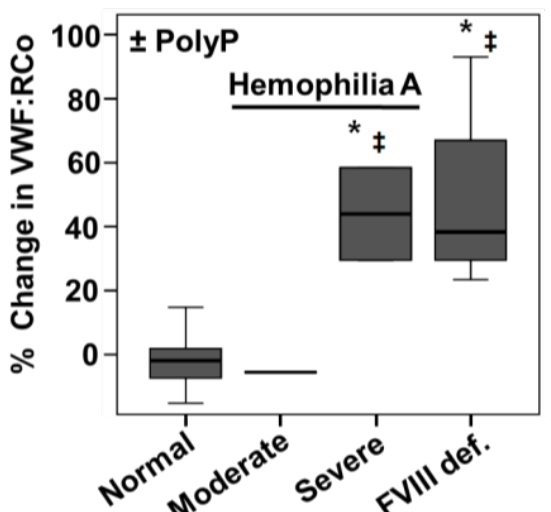
Figure 4. PolyP addition increases the von Willebrand factor activity in plasmas from patients with severe hemophilia A. Experiments were performed as described in Figure 3 but using plasmas from healthy individuals (Normal) and patients with moderate and severe hemophilia A (Moderate, Severe). Quantification of the differences in von Willebrand factor ristocetin co-factor activity after the addition of 2.5 µ M of isolated polyphosphate (polyP 65 ). For each sample, the change was calculated as “activity without addition of polyP” minus “activity with the addition of polyP”. For comparison, we also include data from experiments using factor VIII-deficient plasmas (FVIII-def.). Results are presented in a box-and-whiskers plot. Symbols indicate a statistical difference of p < 0.01,